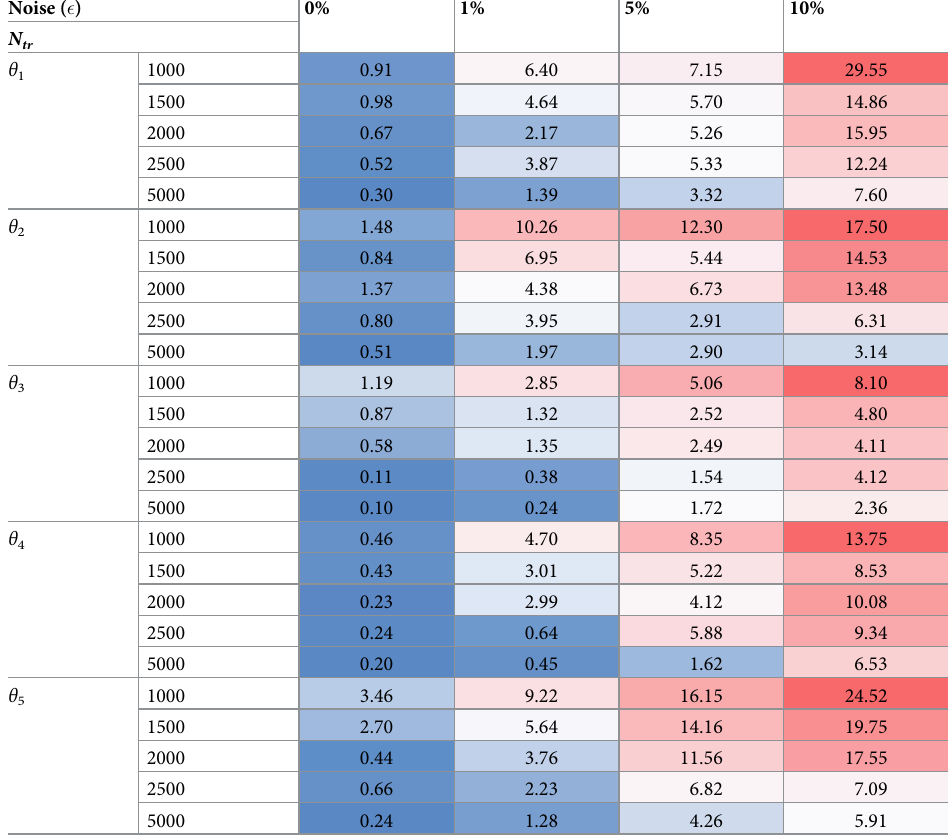
Table 8. Biot’s equations—inverse modeling: PINN performance as function of noise. This figure shows the average percentage errors of θ 1 , θ 2 , θ 3 , θ 4 , and θ 5 for different numbers of training data N tr corrupted by different noise levels ( � ). Here, the neural network architecture is kept fixed to 6 layers and 20 neurons per layer. These results are an average over 10 realizations. Noise ( � ) 0% 1% 5%